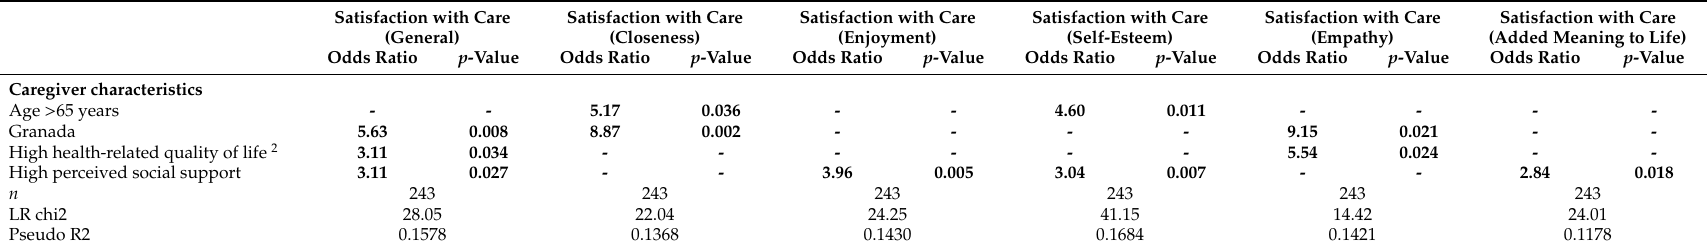
Table 5. Variables associated with informal caregiver satisfaction with caregiving role: multivariate analysis for men 1 . Satisfaction with Care Satisfaction with Care Satisfaction with Care Satisfaction with Care Satisfaction with Care Satisfaction with Care (General) (Closeness) (Enjoyment) (Self-Esteem) (Empathy) (Added Meaning to Life) Odds Ratio p -Value Odds Ratio Odds Ratio p -Value Odds Ratio p -Value p -Value Odds